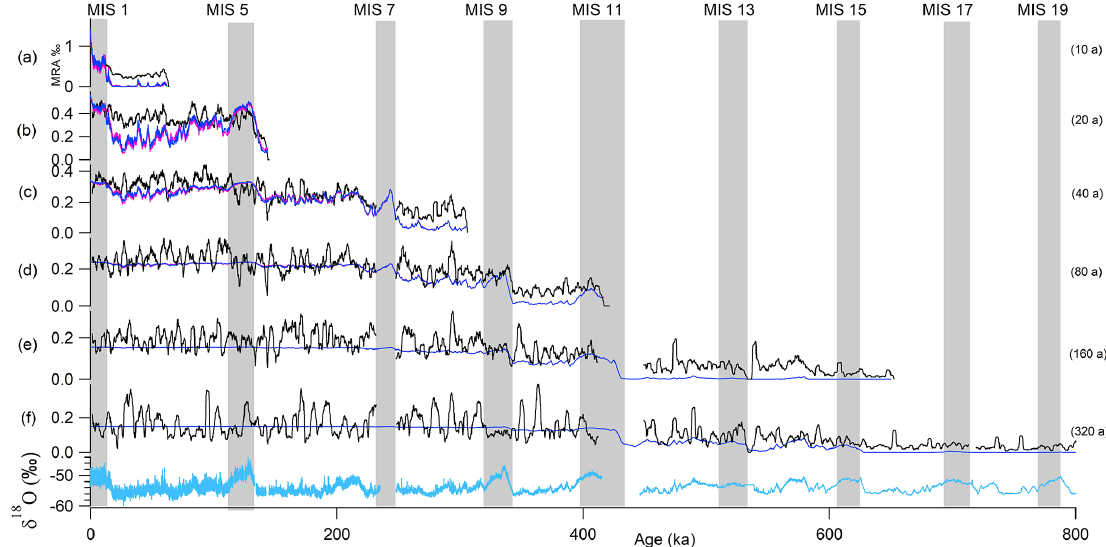
Figure 5. High-resolution record (light blue) and comparison of its variability (3kyr standard deviation, black) to the variability (3kyr standard deviation) of the diffused Holocene signal for the different periods (10, 20, 40, 80, 160 and 320 years for a to f ). The diffused Holocene signal was calculated using two σ firn estimates: a constant σ firn of 7cm (dark blue) and a variable σ firn equal to 6.5cm in glacial periods and 7.5cm in interglacial periods